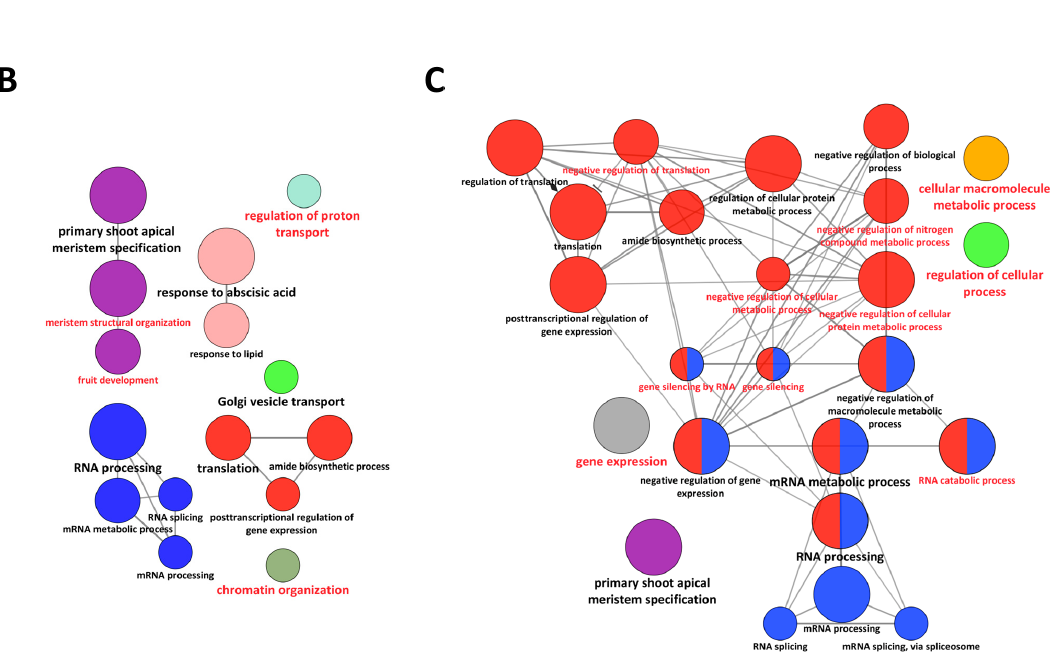
Figure 7. Overrepresented biological processes associated with phosphoproteins identified in dry ( A ) and 24 h DI seeds ( B ) and 24 h LI seeds ( C ). Enriched GO terms were identified using ClueGO application (pV < 0.01; hypergeometric test with Bonferroni pV correction). Node colors identify GO terms belonging to the same GO group. Red labels identify GO terms statistically overrepresented only in the condition analyzed. Detailed data are to be found in Table